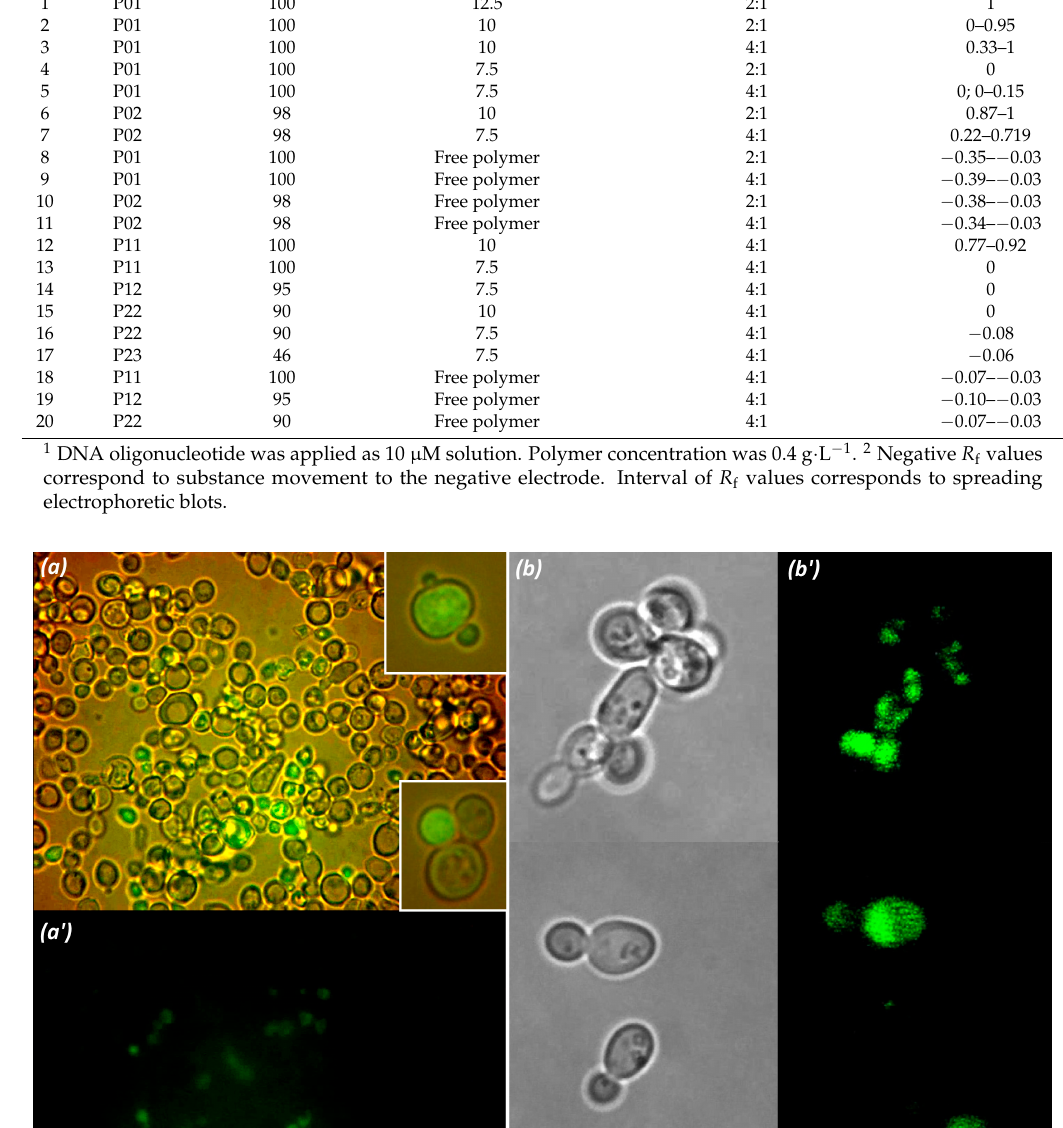
Table 4. Gel electrophoresis results for DNA oligonucleotide complex with new polymers and composites.